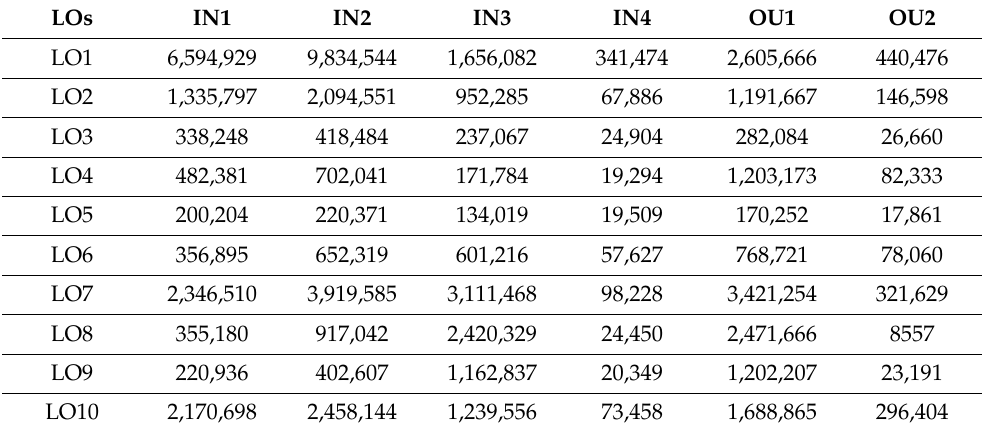
Table 5. Data of 10 LOs in 2020 (Statistics 2021).